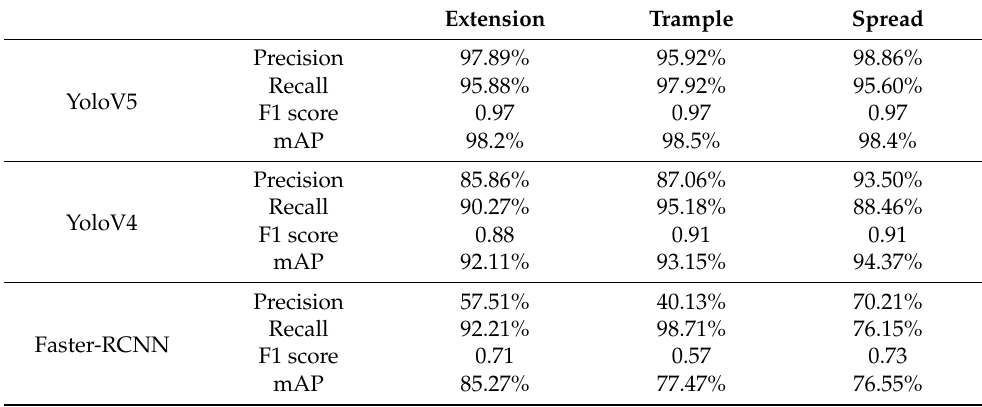
Table 3. The results of different algorithms.